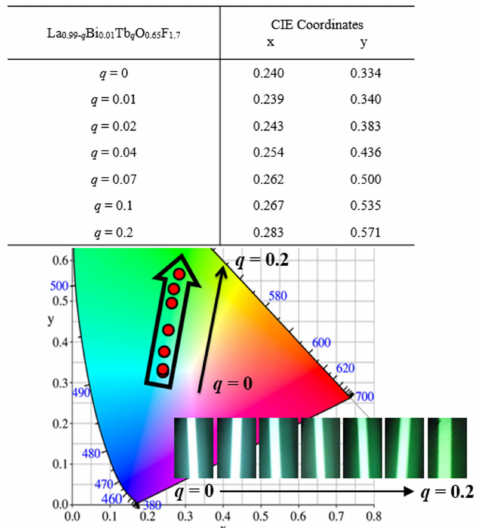
Figure 5. The chromaticity coordinates with the desired CIE values of La 0.99 − q Bi 0.01 Tb q O 0.65 F 1.7 ( q = 0–0.2) phosphors (EX = 286 nm) and photographs of the green emission light of the phosphors under 286 nm radiation.